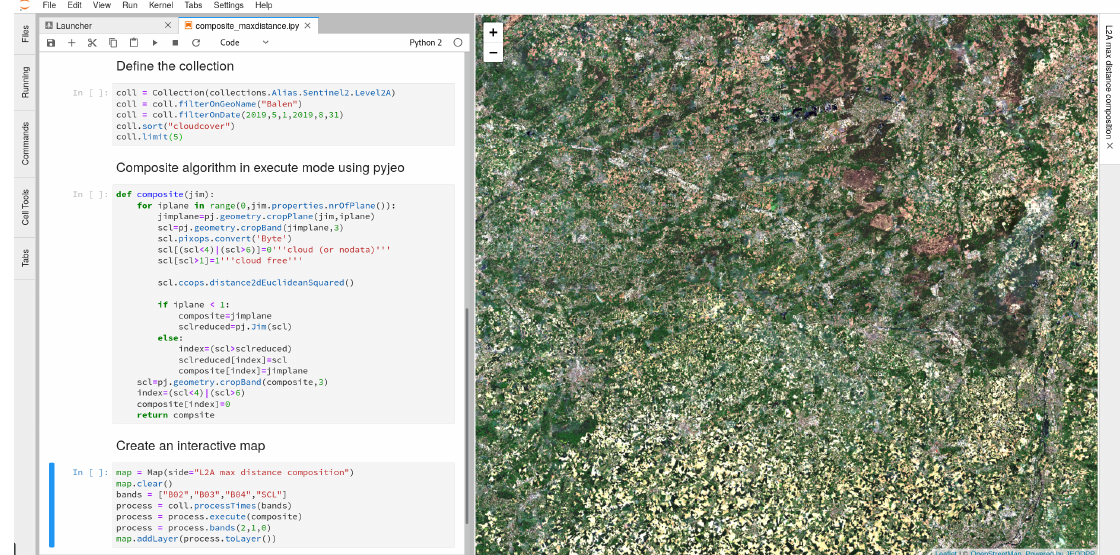
Figure 6. Interactive analysis and visualization in JEO-lab. The definition of the composition function is written in Python using pyjeo functions (left). The execution is performed in deferred processing, where each tile is processed in parallel at the extent and scale the user has visualized in the interactive map viewer